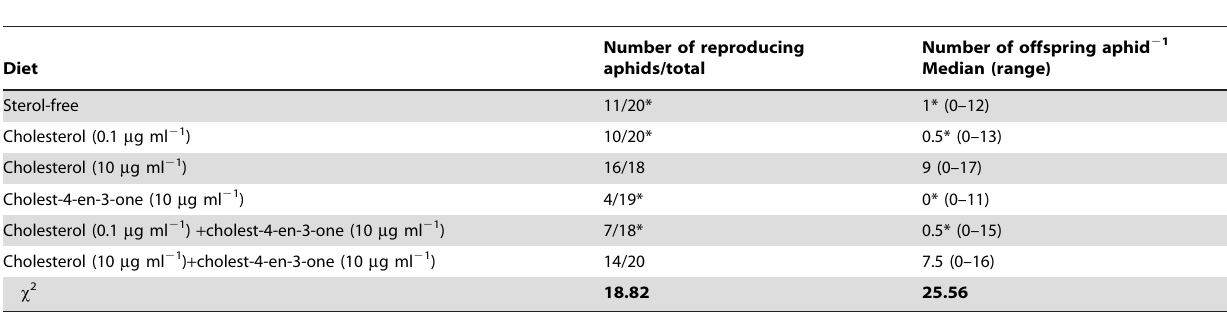
Kruskal-Wallis results are reported for each column, with critical probability=0.025 after Bonferroni correction for two tests. Statistically significant values of x 2 are shown in bold. * indicates a significant reduction compared to 10 m g cholesterol ml 2 1 (p , 0.05).